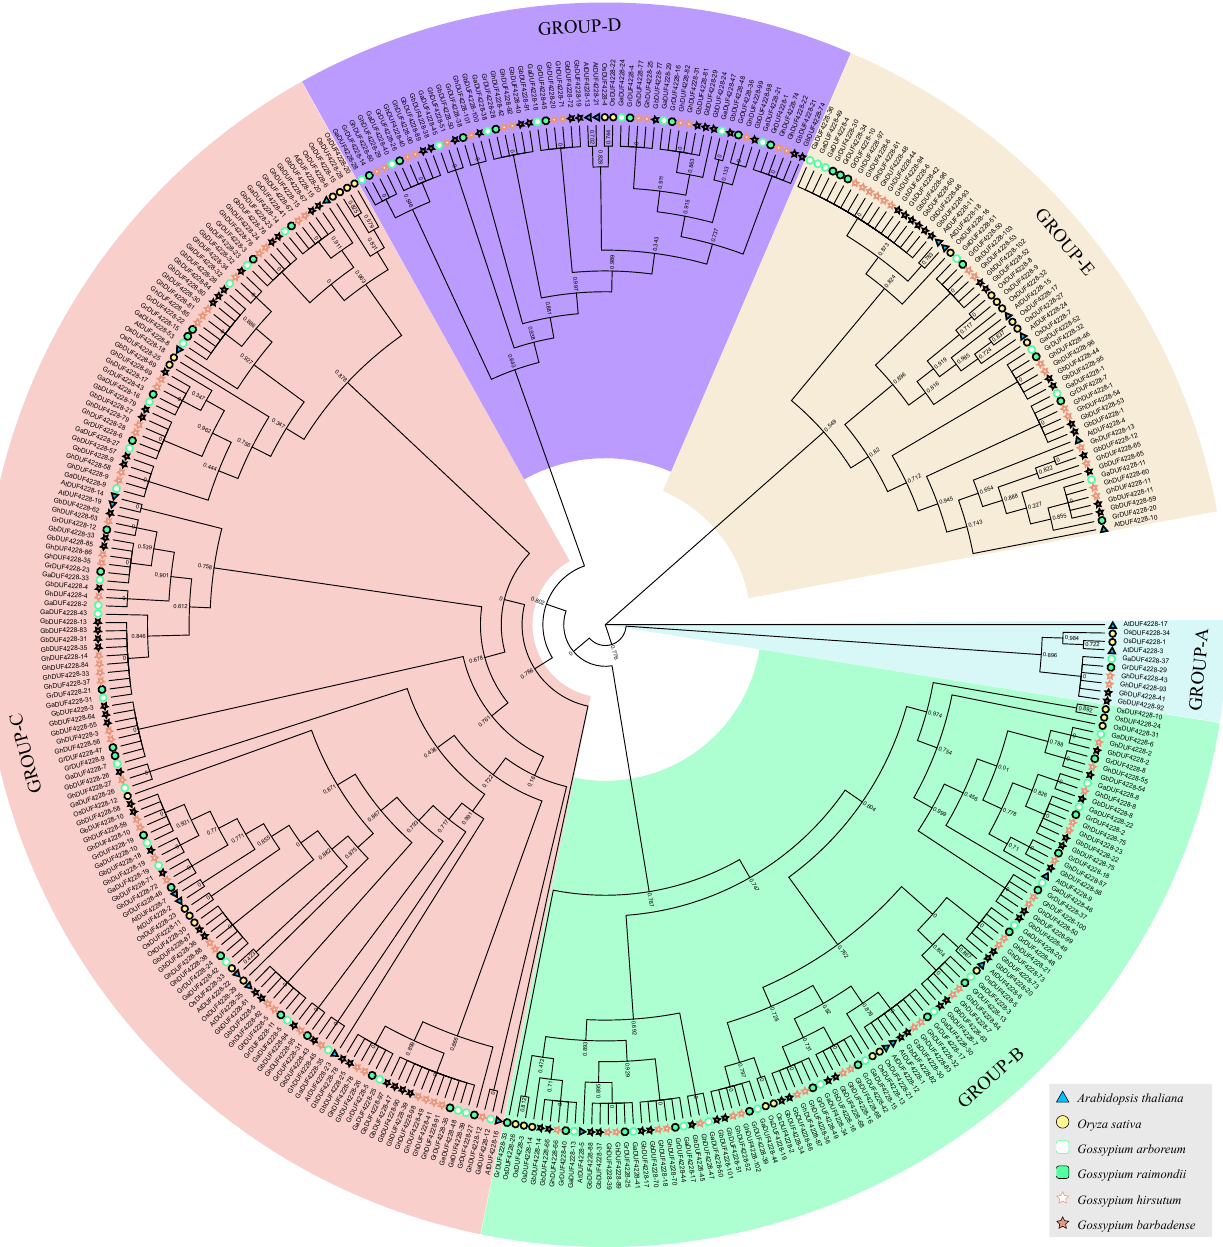
Figure 1. Phylogenetic relationship of DUF4228 proteins from six plant species. A phylogenetic tree was constructed using FastTree from 367 DUF4228 proteins from Arabidopsis thaliana , Oryza sativa , Gossypium hirsutum , Gossypium barbadense , Gossypium arboretum, and Gossypium raimondii, and the phylogenetic tree was divided into five subfamilies. The five subfamilies are represented by different background colors, and the six species are represented by different traits and